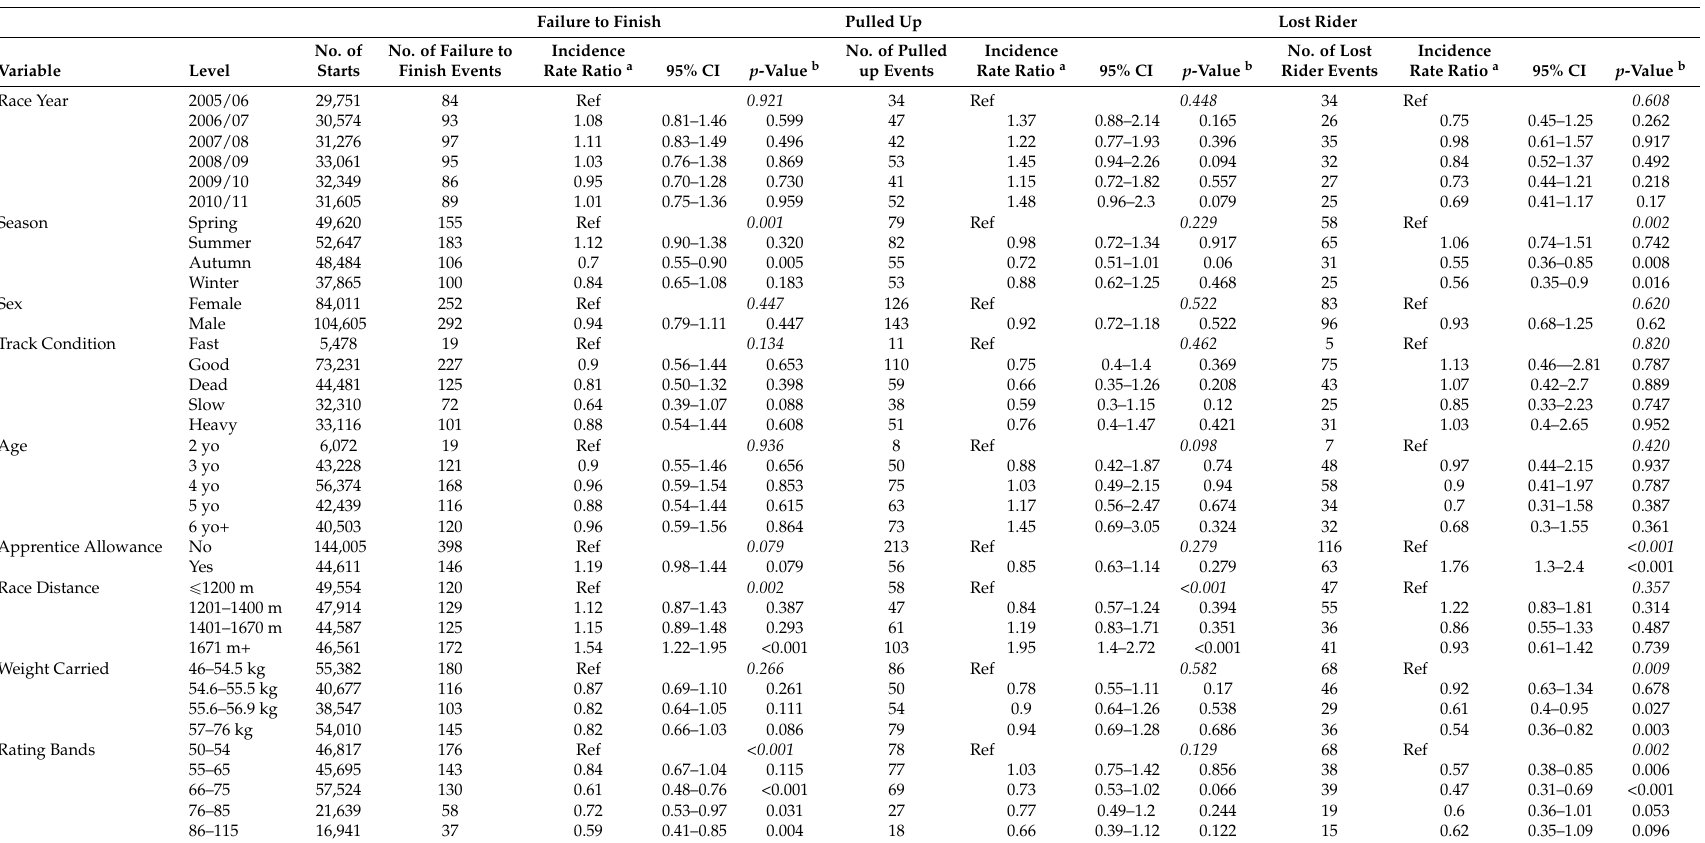
Table 1. Univariable Poisson regression for the outcomes failure to finish, pulled-up and lost rider showing incidence rate ratios (IRR) for all Thoroughbred flat race starts in the 2005/06–2010/11 racing years in New